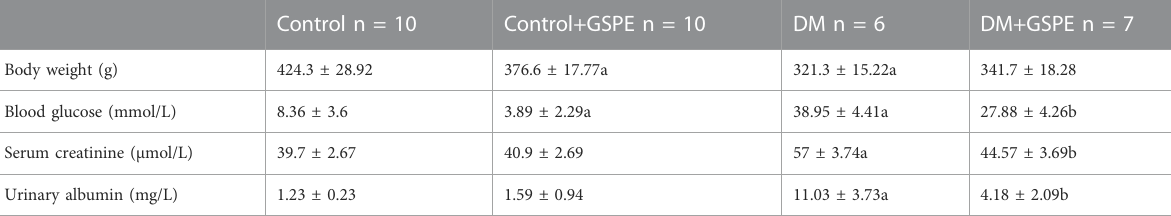
TABLE 1 Characteristics of the rats at the end of the experiment. Mean ± SD.